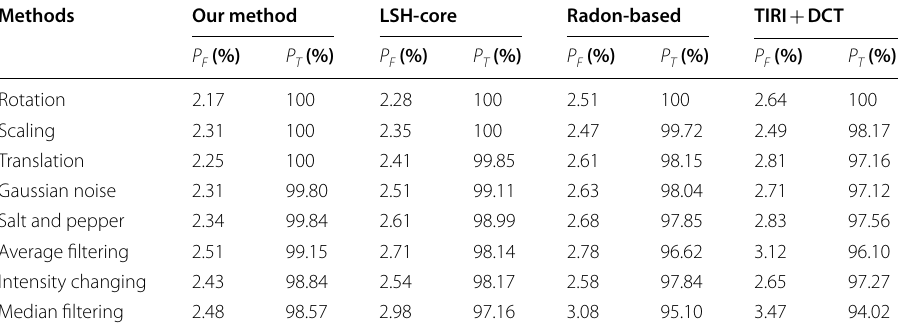
Here shown in this table are the false positive rates and true positive rates for all four methods under various operations. The listed each operation has the averaged results for each method at each row. The higher the true positive rate, the better the robustness; likewise, the lower the false positive rate, the better the sensitivity the method has